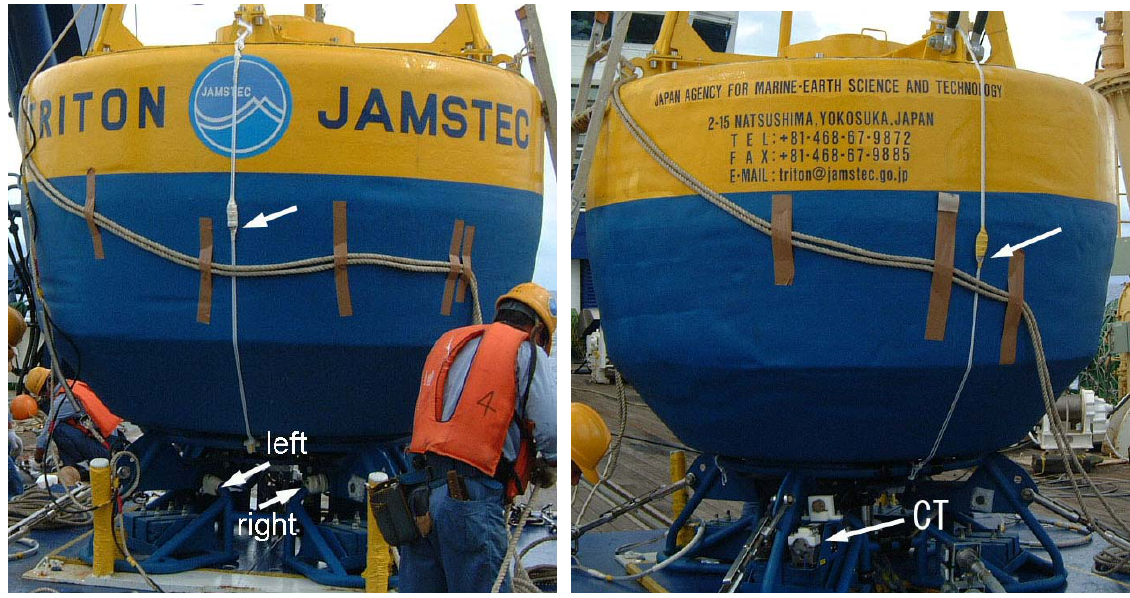
Figure 2. Photograph showing the hull of the TRITON buoy and the specially attached thermometers on the “mark” side (left photograph) and the “opposite” side (right photograph). The boundary between yellow and blue sections of the hull indicates the water-line. The white arrows point to the thermometers. The upper two thermometers were attached using white